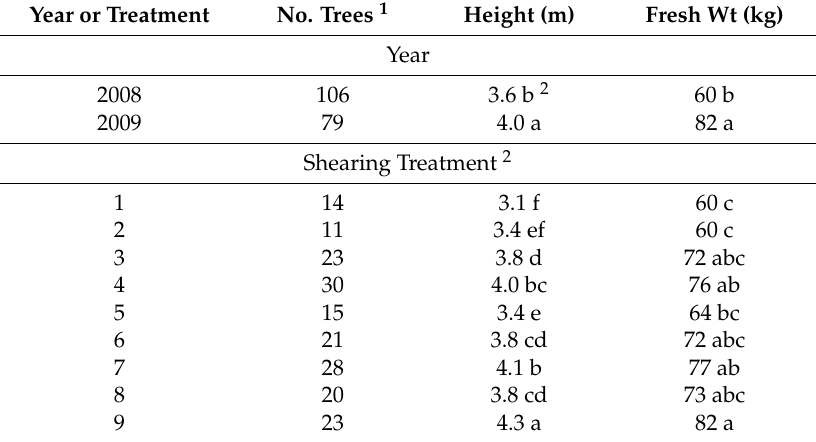
Table 3. Height and fresh weight of 185 Fraser fir Christmas trees sheared with various leader